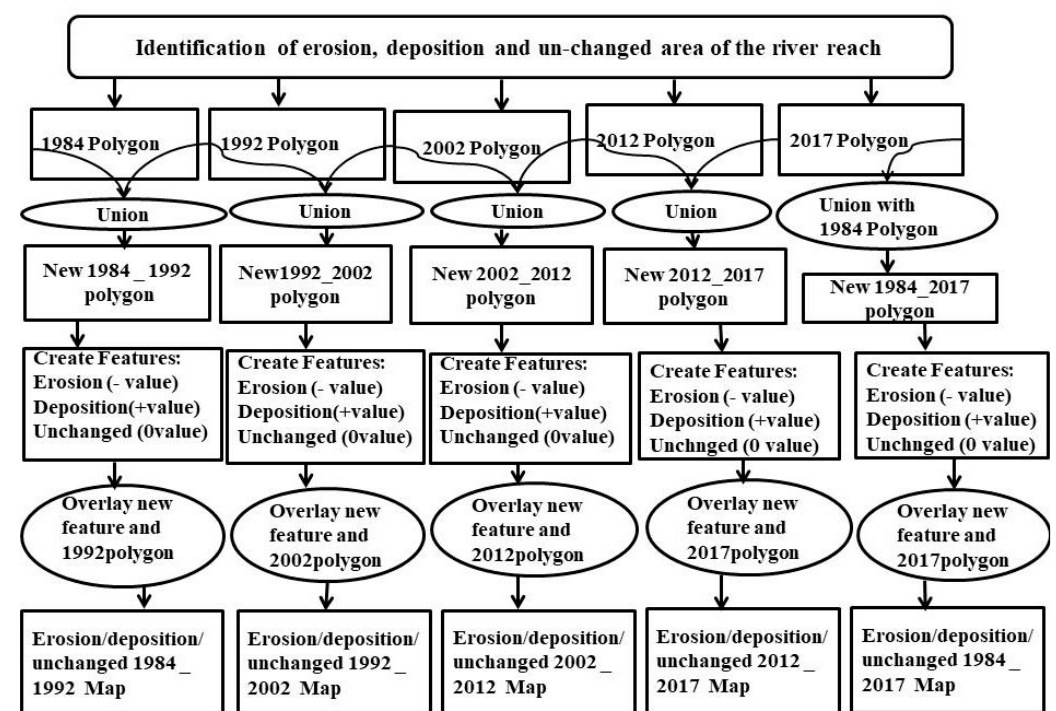
Figure 2. Flowchart analysis of channel changes and dynamics of the Barak River.